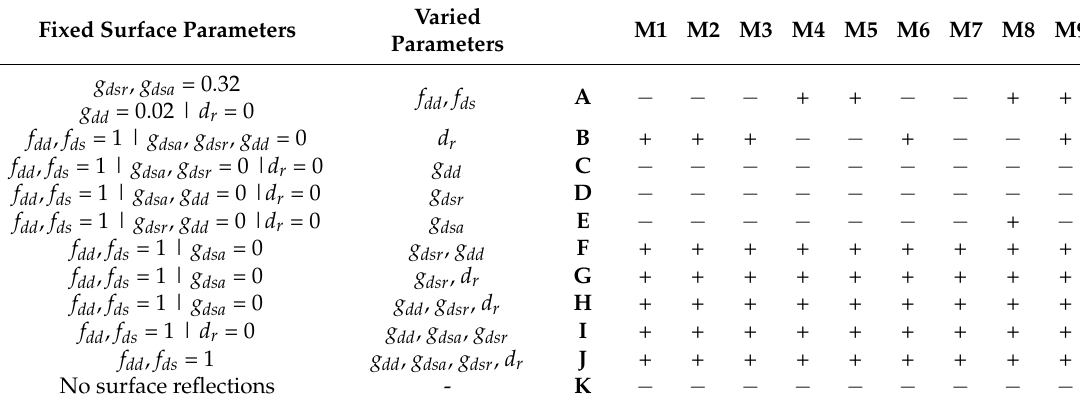
Fixed Surface Parameters